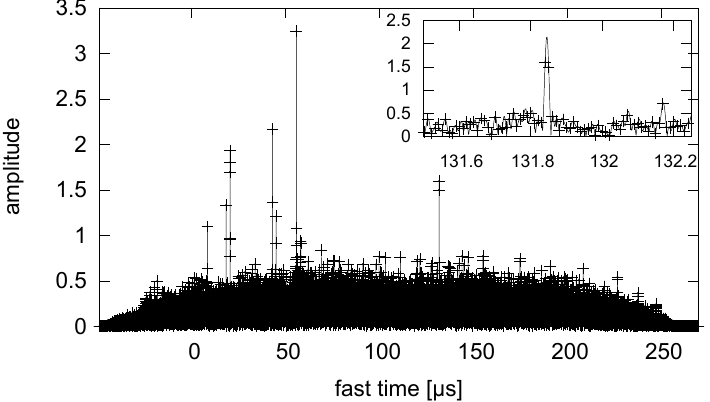
Figure 2. Range compressed data of a single range line containing the target response of a corner reflector at 131.84 µ s. The origin ( τ = 0) corresponds to the start of the receiving window; artificial data points for a negative fast time result from the match filter